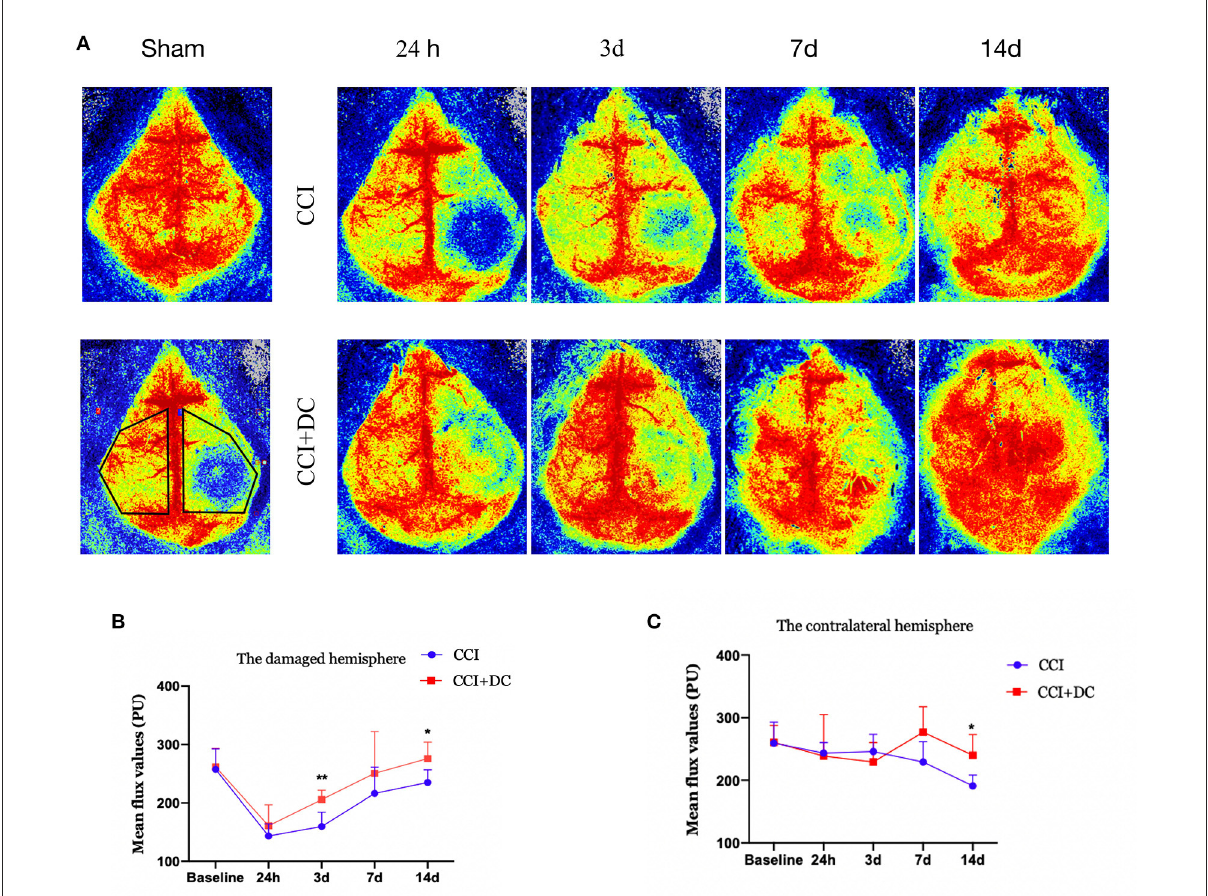
FIGURE7 Effects on cerebral blood flow. (A) Laser speckle test was performed at different time points after CCI to evaluate cerebral blood flow, and the statistical results were shown in (B,C) . (B) It was statistically found that the cerebral blood flow on the injured side of the CCI + DC group after CCI was higher than that of the CCI group, and the results were statistically different on the 3rd and 14th day after CCI. (C) Statistically, cerebral blood flow in the healthy side of the CCI + DC group was higher than that in the CCI group on the 7th day after CCI, and the difference was statistically significant ( n = 5/group, * P < 0.05, ** P < 0.01, vs. CCI